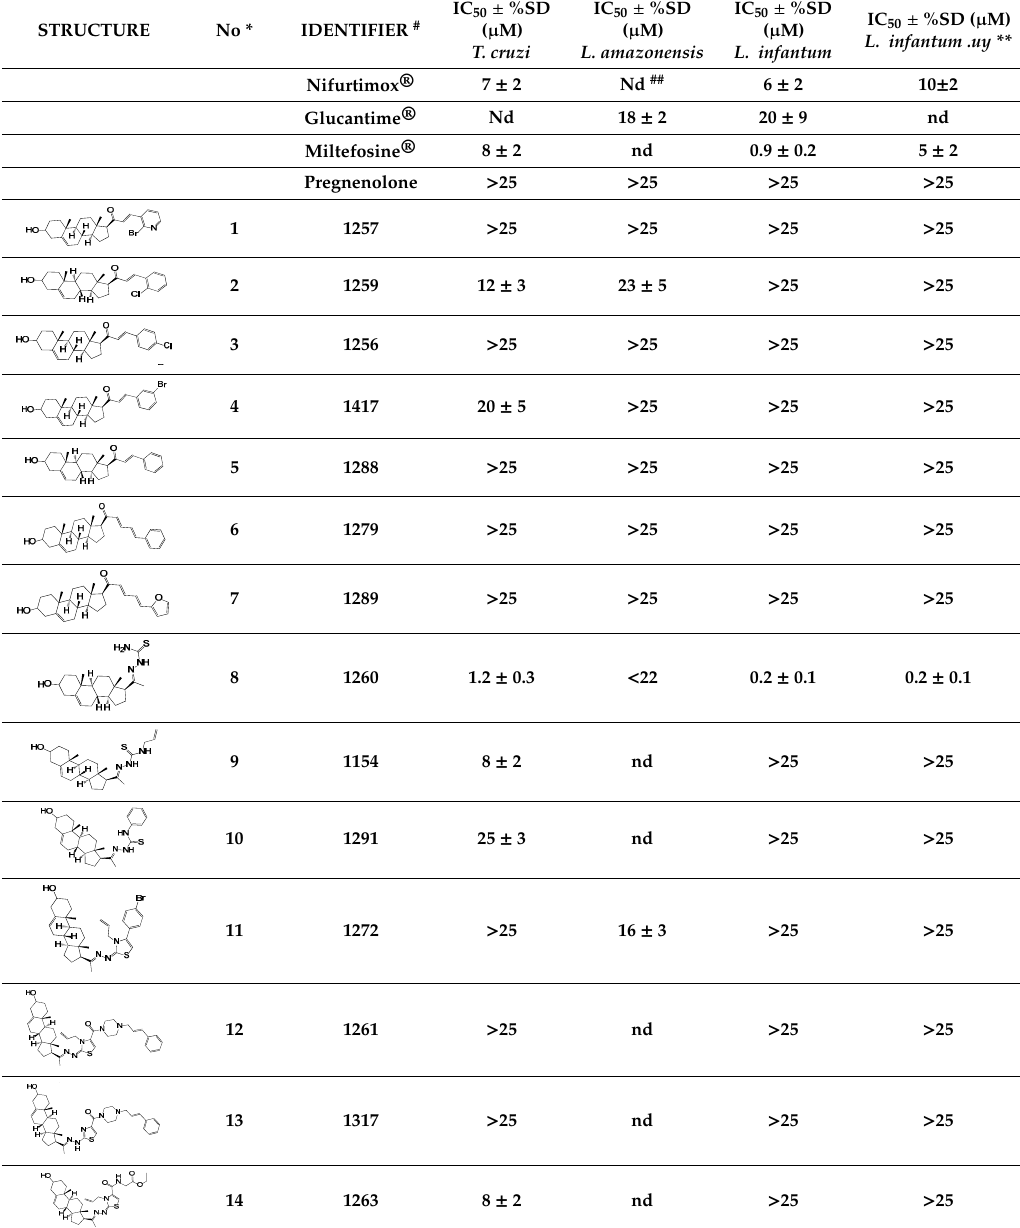
Table 1. Trypanocidal activity against T. cruzi (epimastigotes), L. amazonensis (promastigotes) and L. infantum (promastigotes).